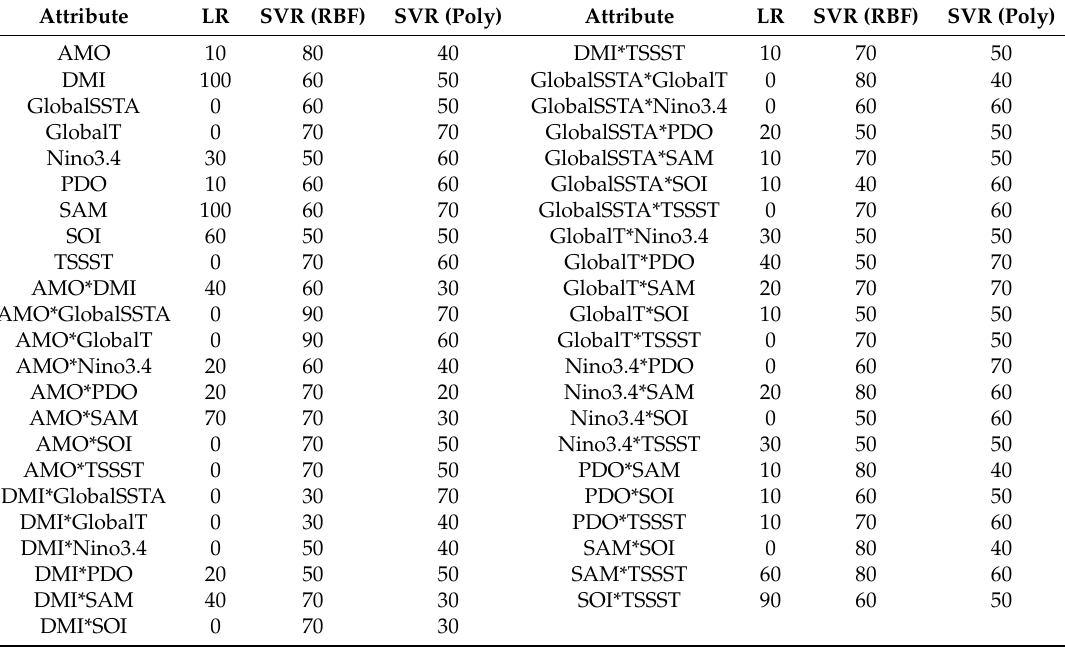
Table 1. Percentage of folds selecting attributes for precipitation using LR, and SVR with the radial basis (RBF) and polynomial (poly) kernel